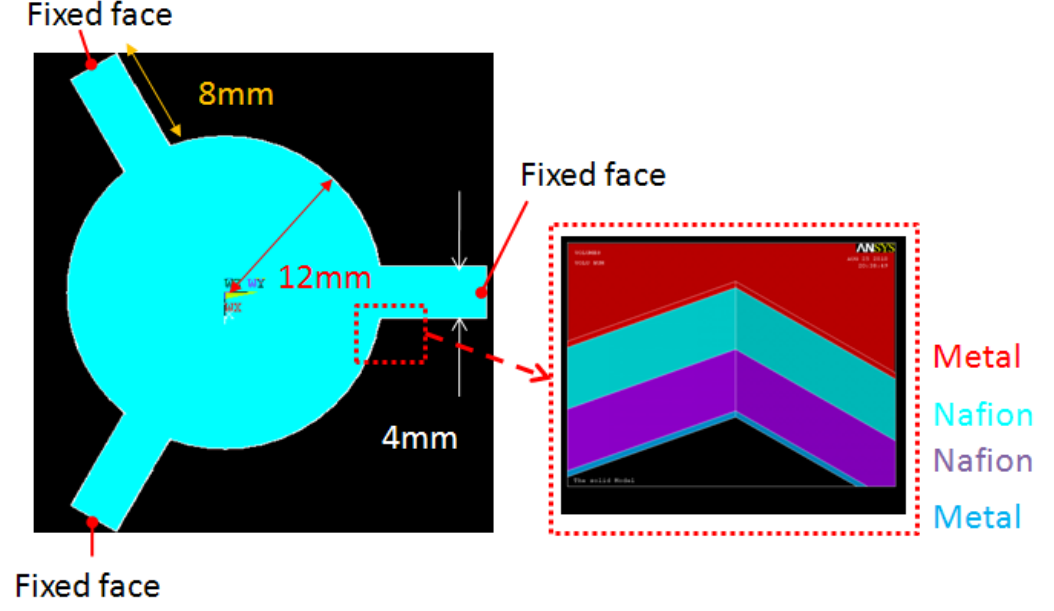
Figure 5. The structure model in ANSYS ® of a gear shaped IPMC design.